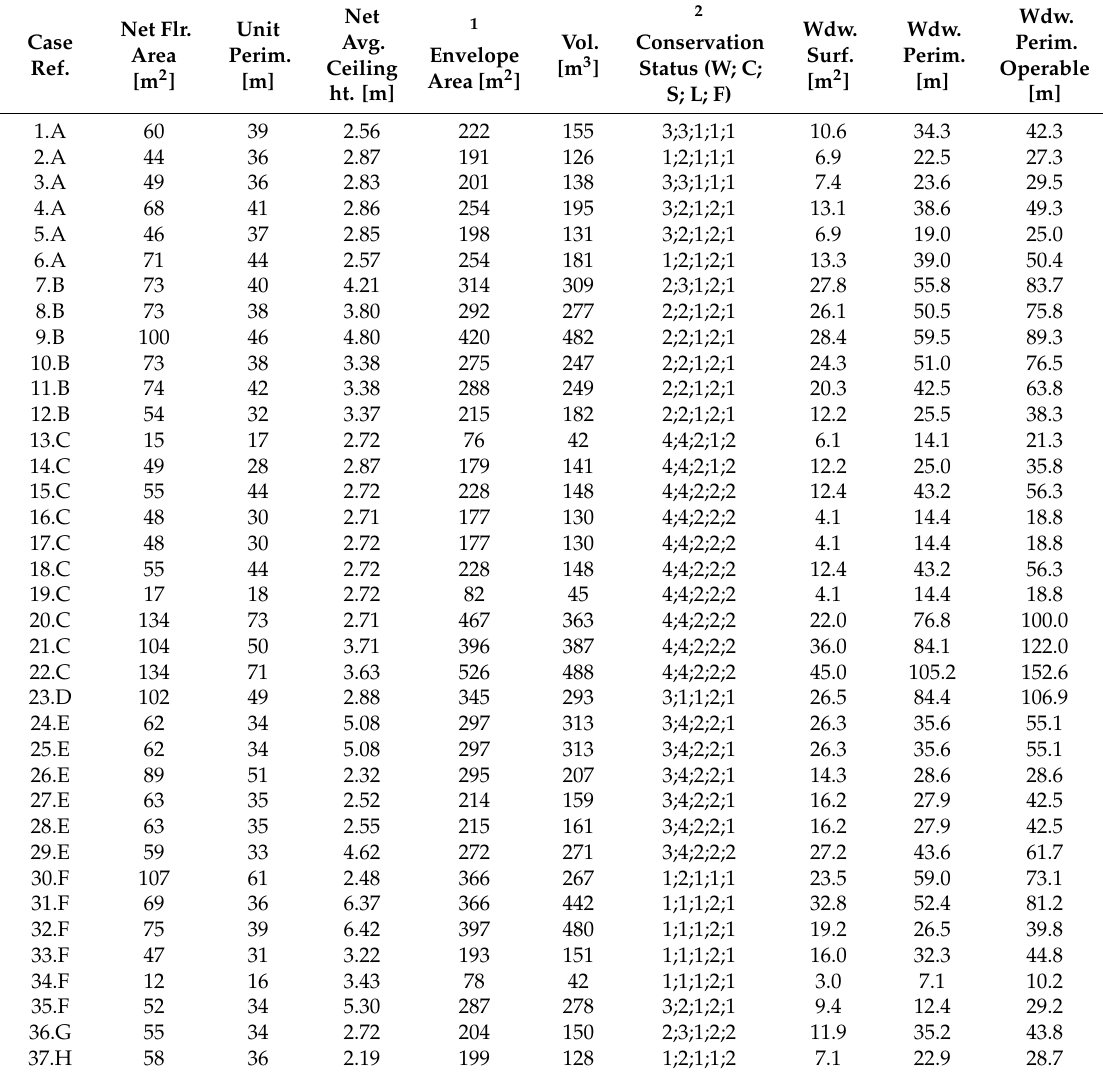
Table 5. Case studies characteristics and tested enclosure